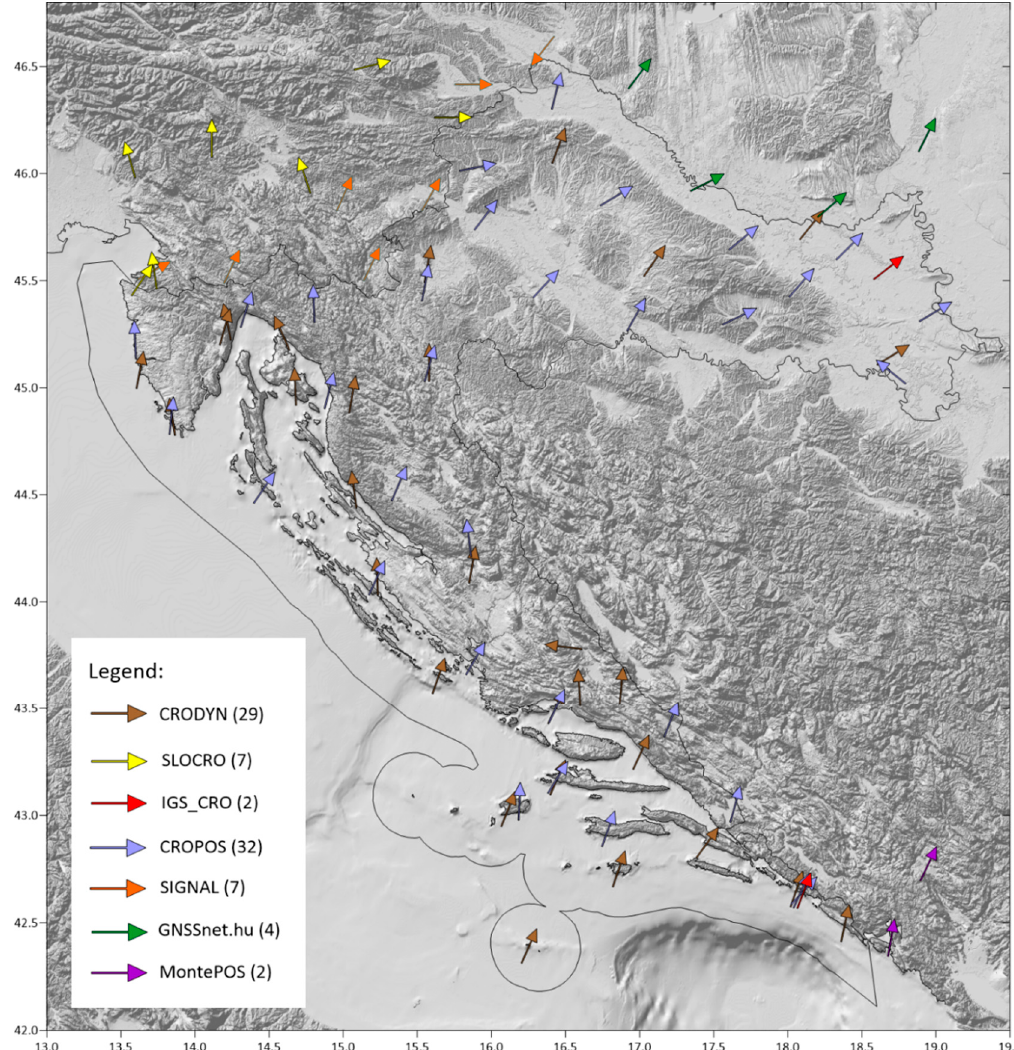
Figure 2. Relative velocity vectors (horizontal component v H ) of 83 stations for the territory of Croatia, Slovenia, Hungary, and Montenegro concerning station GRAZ (all velocity vectors have the same scale). CRODYN includes the Croatian stations that are most frequently observed in campaigns from Table 1.